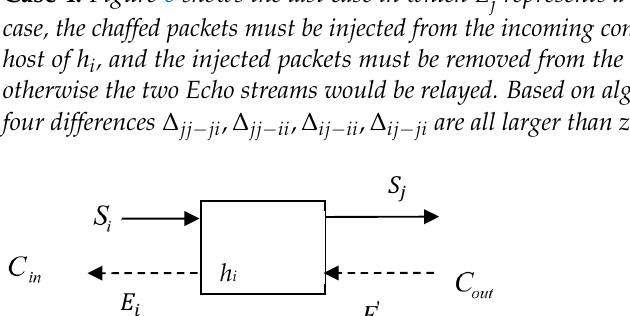
Figure 5. Incoming Echo stream is chaffed.